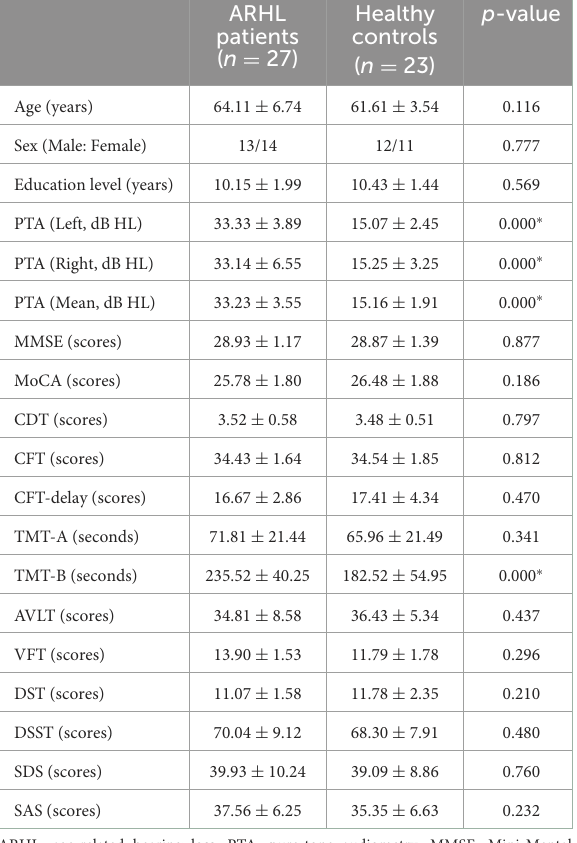
TABLE 1 Demographic and cognitive data in patients with ARHL and healthy controls.